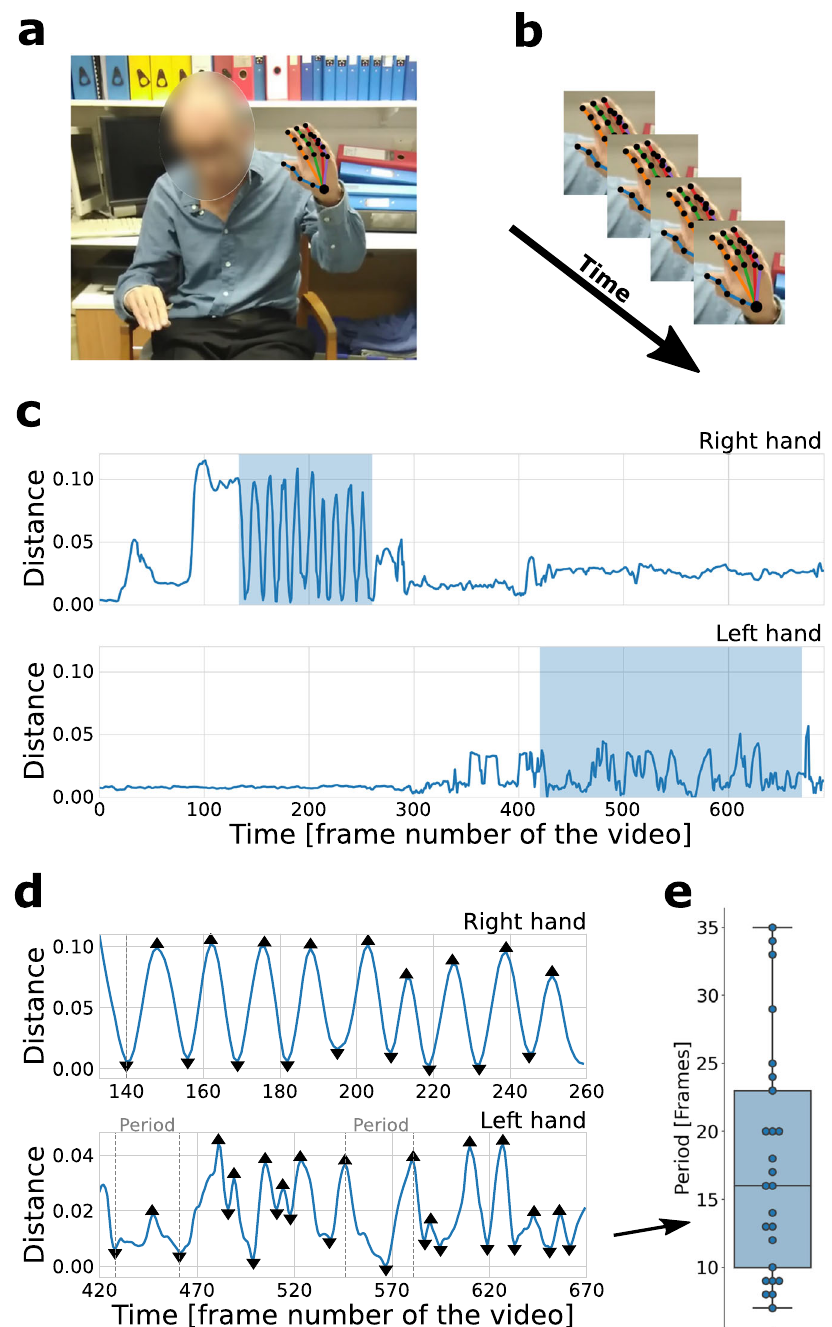
Fig. 6 Feature extraction overview. a The deep learning library OpenPose 44 was used to extract 25 body and 21 hand key points from each frame of the video. The photograph is published with written consent from the patient. b Coordinates of the key points across the frames were used to construct time-series signals. c An example of fi nger-tapping signals (i.e. Euclidean distance between index fi nger tip and thumb-tip key points) for right (top) and left (bottom) hand. In this case, the right hand received a low severity score of 1, while the left hand received a high severity score of 4. The highlighted regions depict the regions of interest (ROIs); i.e. when the action was performed. d Detected peaks and troughs on the signals of the two ROIs for the right hand (top) and left hand (bottom). Features were constructed from these signals. The time between peaks corresponds to the time between successive fi nger taps. e The distribution of periods (in number of frames between consecutive peaks and troughs) is extracted from the lower panel (left-hand signal) of (D). The box ranges from the fi rst quartile (Q1) to the third quartile (Q3) of the distribution, the median is indicated by the center line, the whiskers indicate the distance 1.5*IQR (interquantile range) below Q1 and above Q3. One of the features, range of period between actions, is calculated as maximum minus minimum